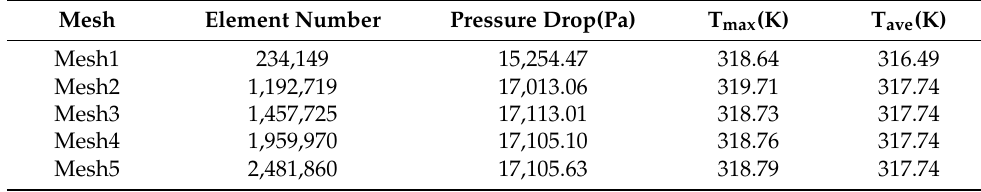
Figure 4. Local mesh of model 3. Table 3. Grid independence verification. Table 3. Grid independence verification.